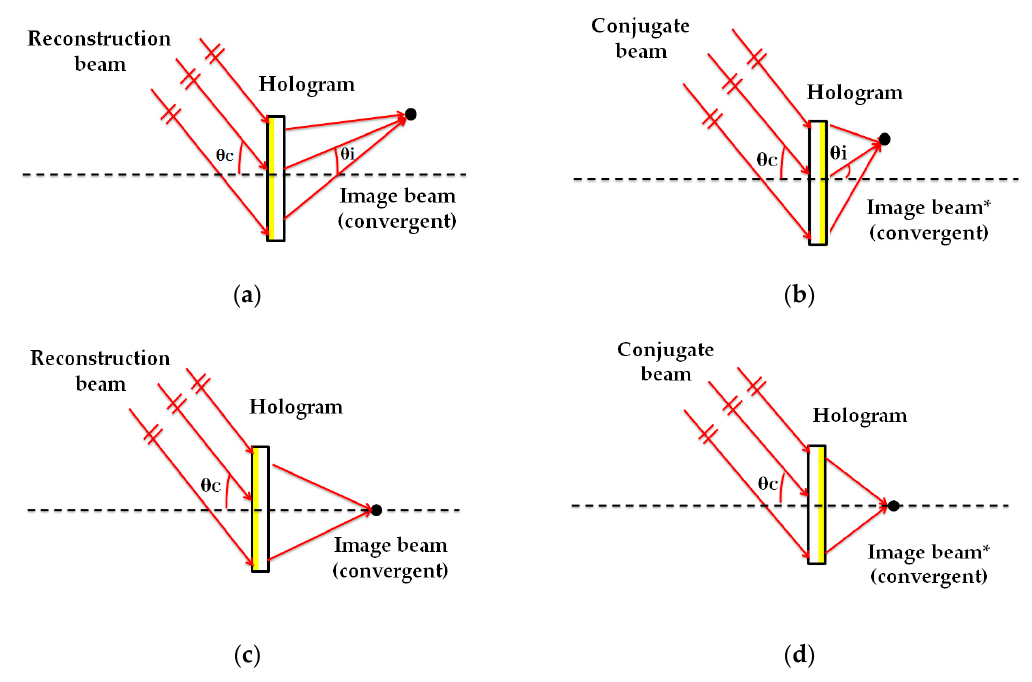
Figure 2. Holographic storage reconstruction (473 nm and 633 nm) of symmetric ( a ) and ( b ), and asymmetric ( c ) and ( d ) geometry; and with positive ( a ) and ( c ), and negative ( b ) and ( d ) focal points. Table 1. Parameters for the recording of the HLs.